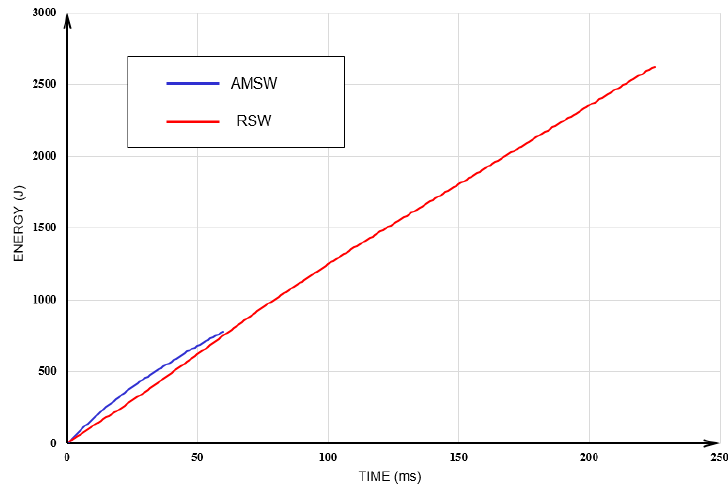
Figure 7. Comparison of electrical energy between the spot welding process using additive manufacturing (AMSW) and the resistance spot welding (RSW) process on zinc-coated sheets.